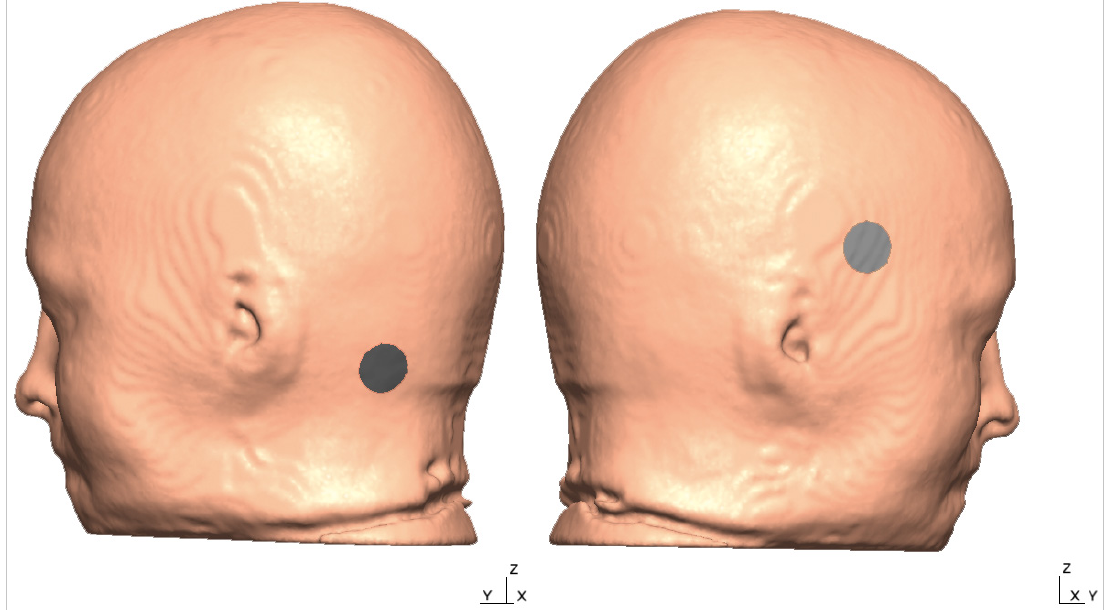
Figure A1. The head model from the 55 − 59 years old MRI template is shown below with two tentative electrode locations and the X, Y, and the Z − direction of the global coordinate system.